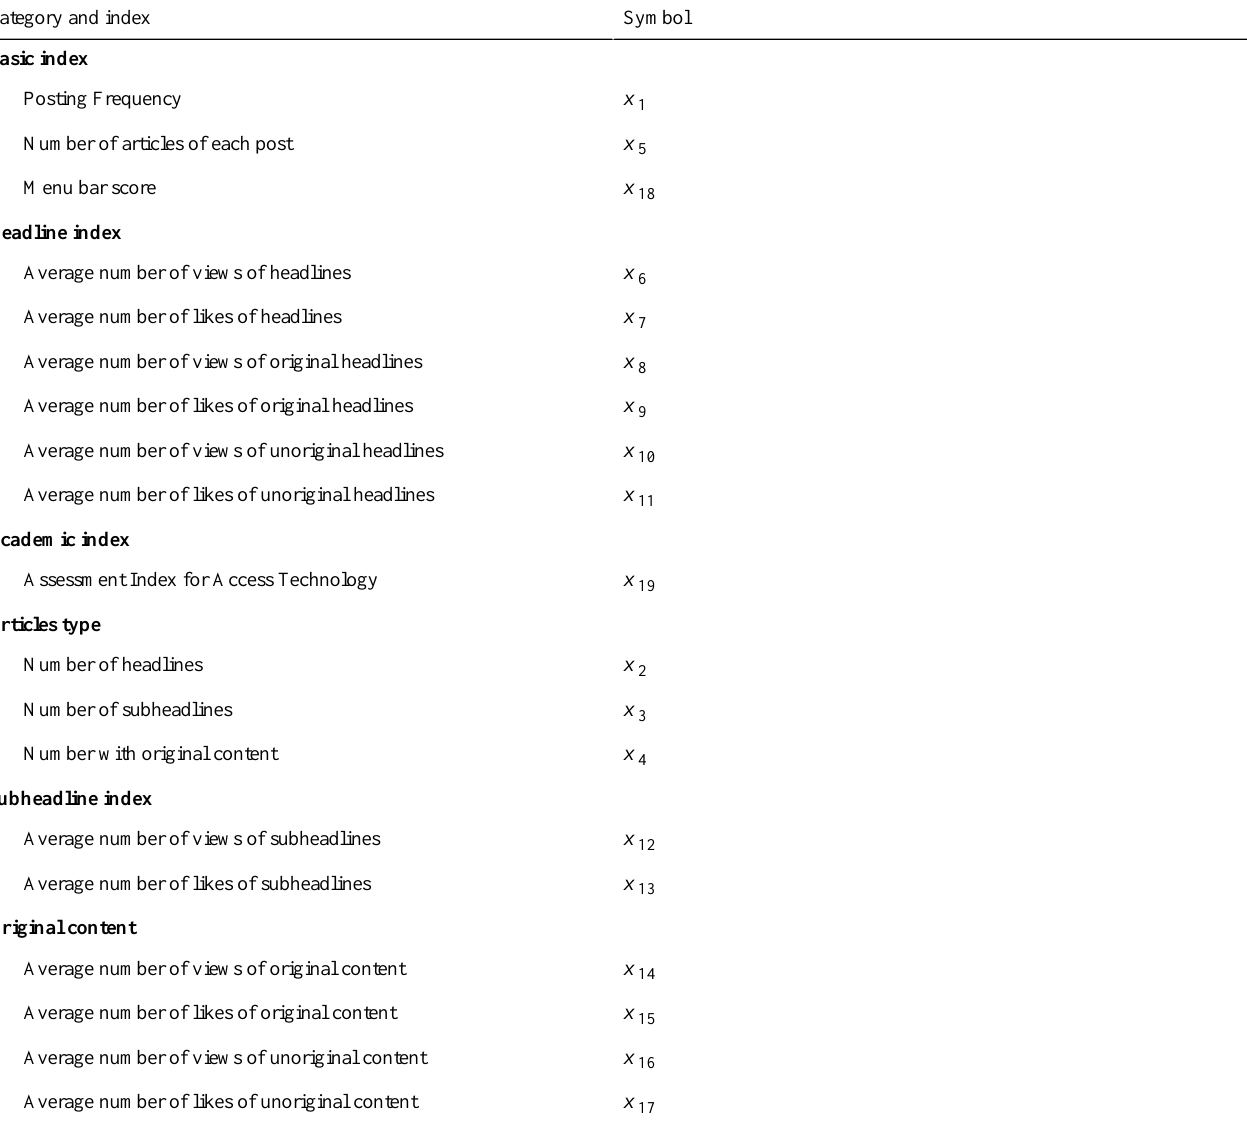
Table 2. The index of internet influence for assisted reproductive technology